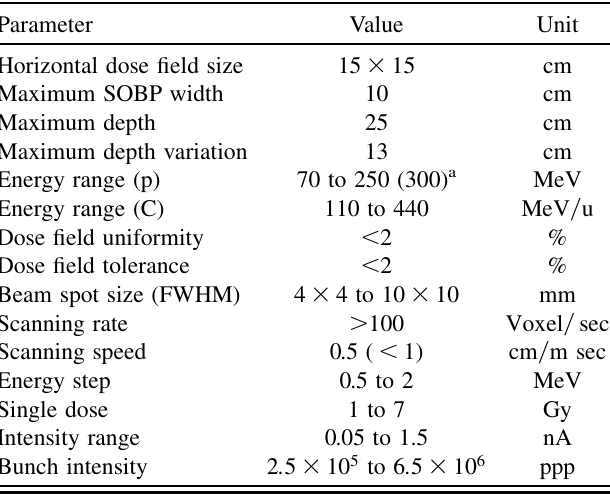
TABLE I. Summary of clinical requirement of PAMELA. Parameter